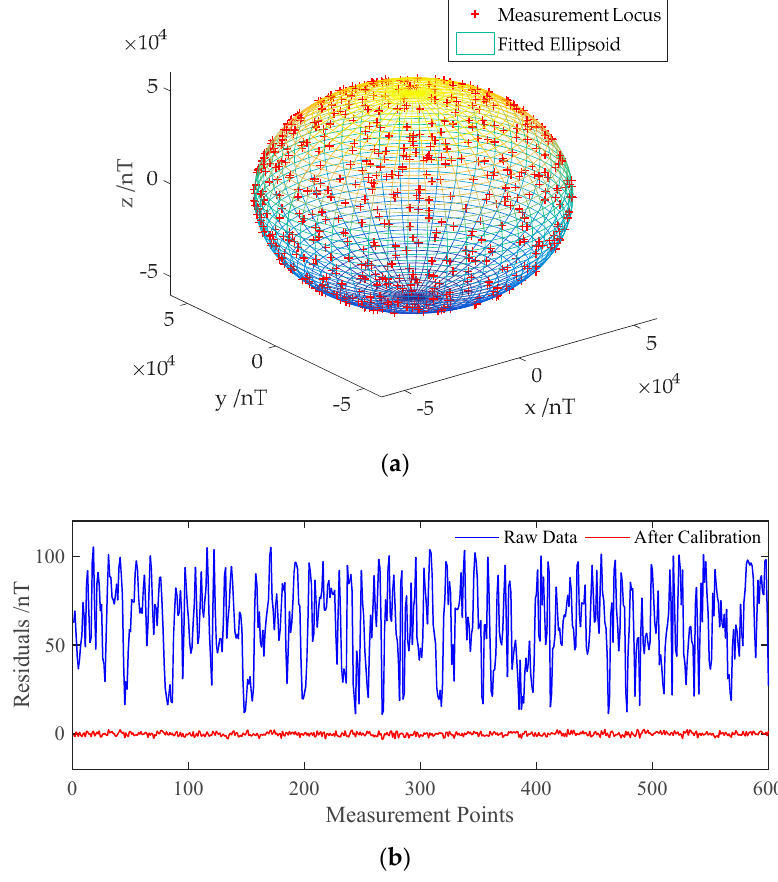
Figure 5. Calibration result of magnetometer error: ( a ) The measurement locus and the fitted ellipsoid; ( b ) The residual of total field after calibration.